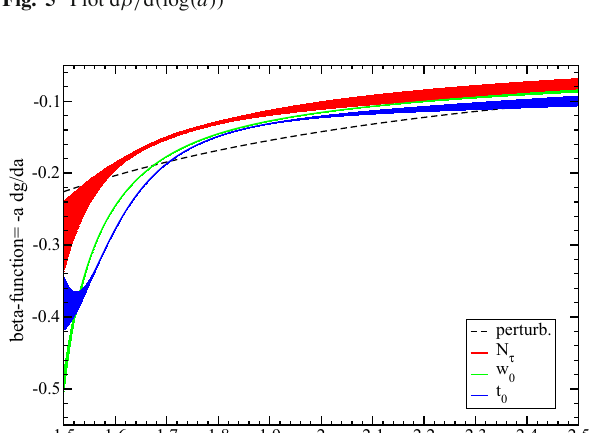
Fig. 6 Plot β -function